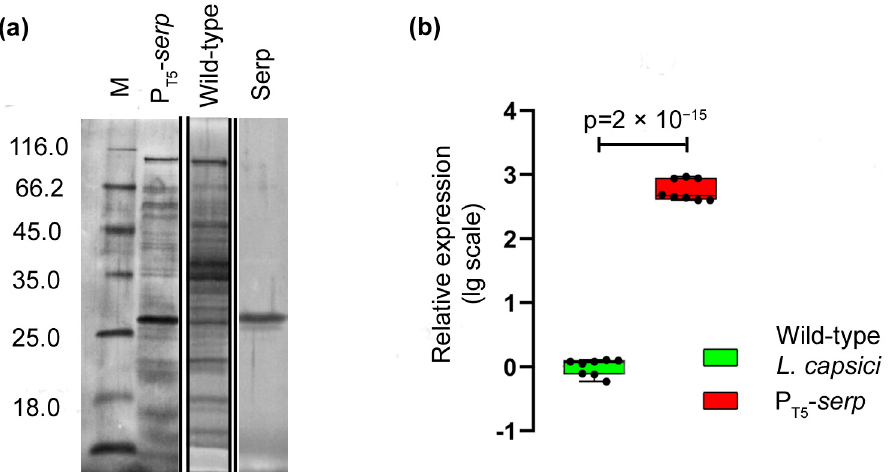
Figure 6. Assessment of the possibility of using the developed expression system for other L. capsici proteins. ( a ) SDS-PAGE: Lanes correspond to samples of culture liquid of L. capsici strains and purified serine protease (Serp) of L. capsici VKM B-2533 T (Supplementary Figures S10–S12). The gel was stained with imidasole–ZnCl 2 solution. ( b ) Relative level of expression of the serp gene of L. capsici serp P T5 as compared with wild-type L. capsici . The boxplots show the median and IQR. The values were obtained in four independent experiments, each with two technical replicates. The two groups were compared using an unpaired two-tailed Student’s t -test, t = 37.41, df = 14.